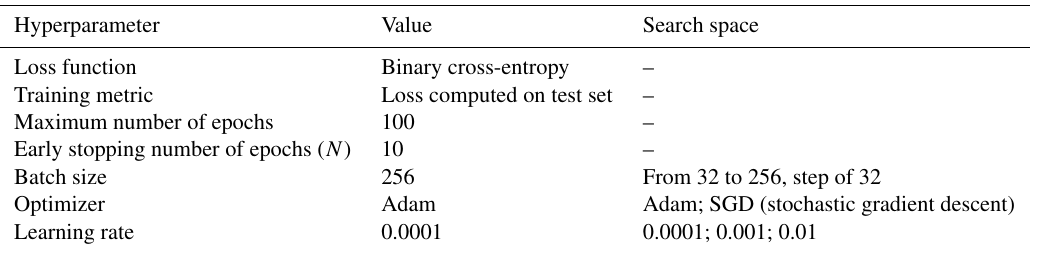
Figure 4. Channels (left to right) of the cyclone image on 22 August 1987, 00:00UTC, centered on 35.5 ◦ N, 43.125 ◦ W. The different rows show the native and interpolated images from ERA5 and MERRA-2 as per the labels. Data are standardized. Table 6. Optimal hyperparameter